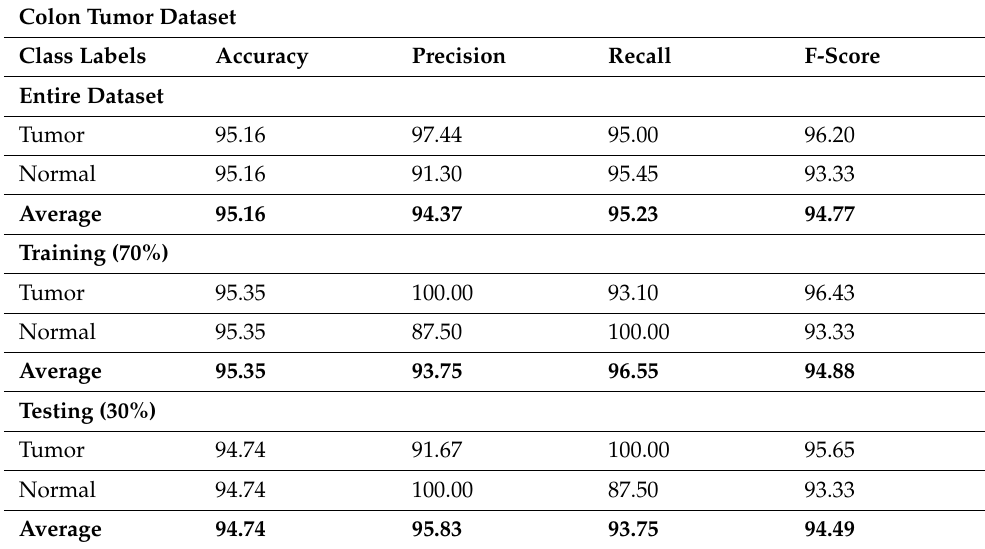
Table 3. Resulting analysis of RFODL-MGEC technique with various measures on colon tu- mor dataset.